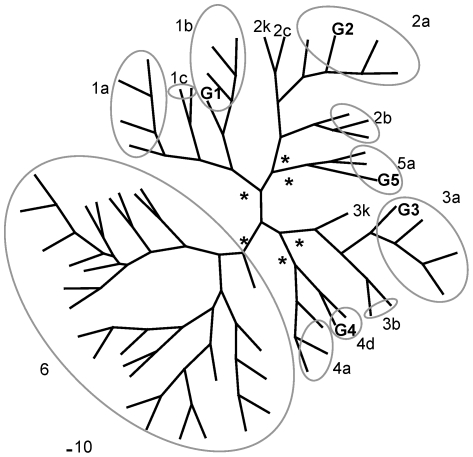
Phylogenetic analysis.Neighbor-joining phylogram of NS5BΔ21 from this study (G1, G2, G3, G4 and G5) and the same reference sequences as in A). A consensus for genotype 6 has also been included. Bootstrap analysis was performed with 100 repetitions. *  =  bootstrap values of 100% showing the divergence of the different genotypes.